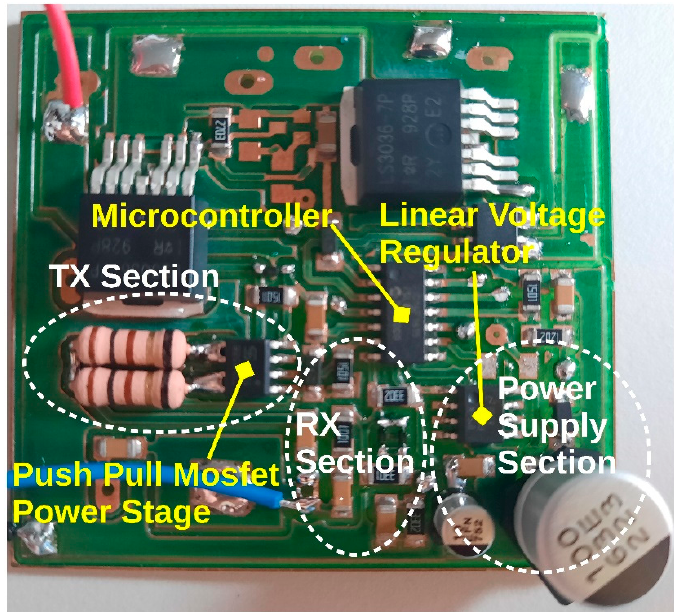
Figure 4. Picture of the real circuit used for testing.